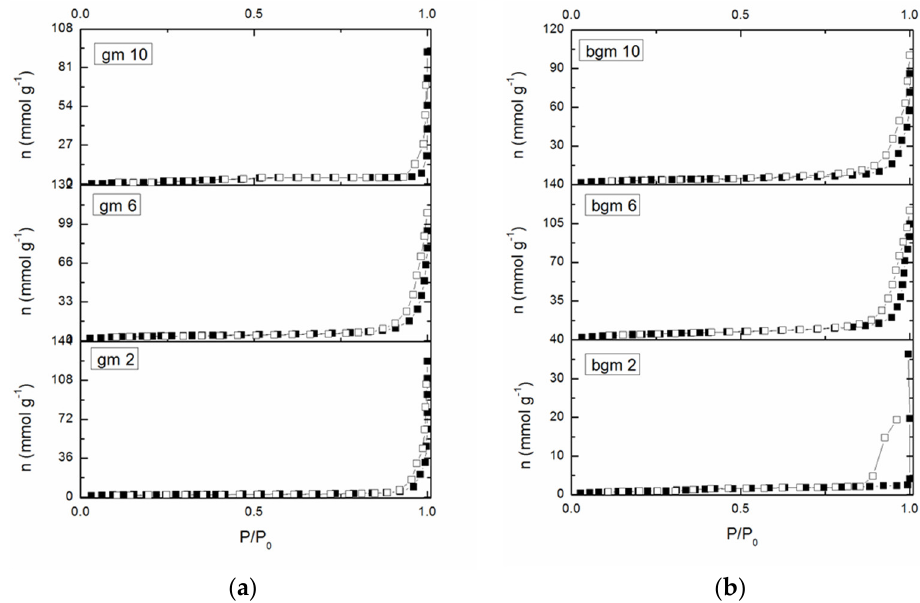
Figure 4. Nitrogen adsorption isotherm plot for ( a ) GM and ( b ) BGM samples. Solid symbols-adsorption; open symbols-desorption.